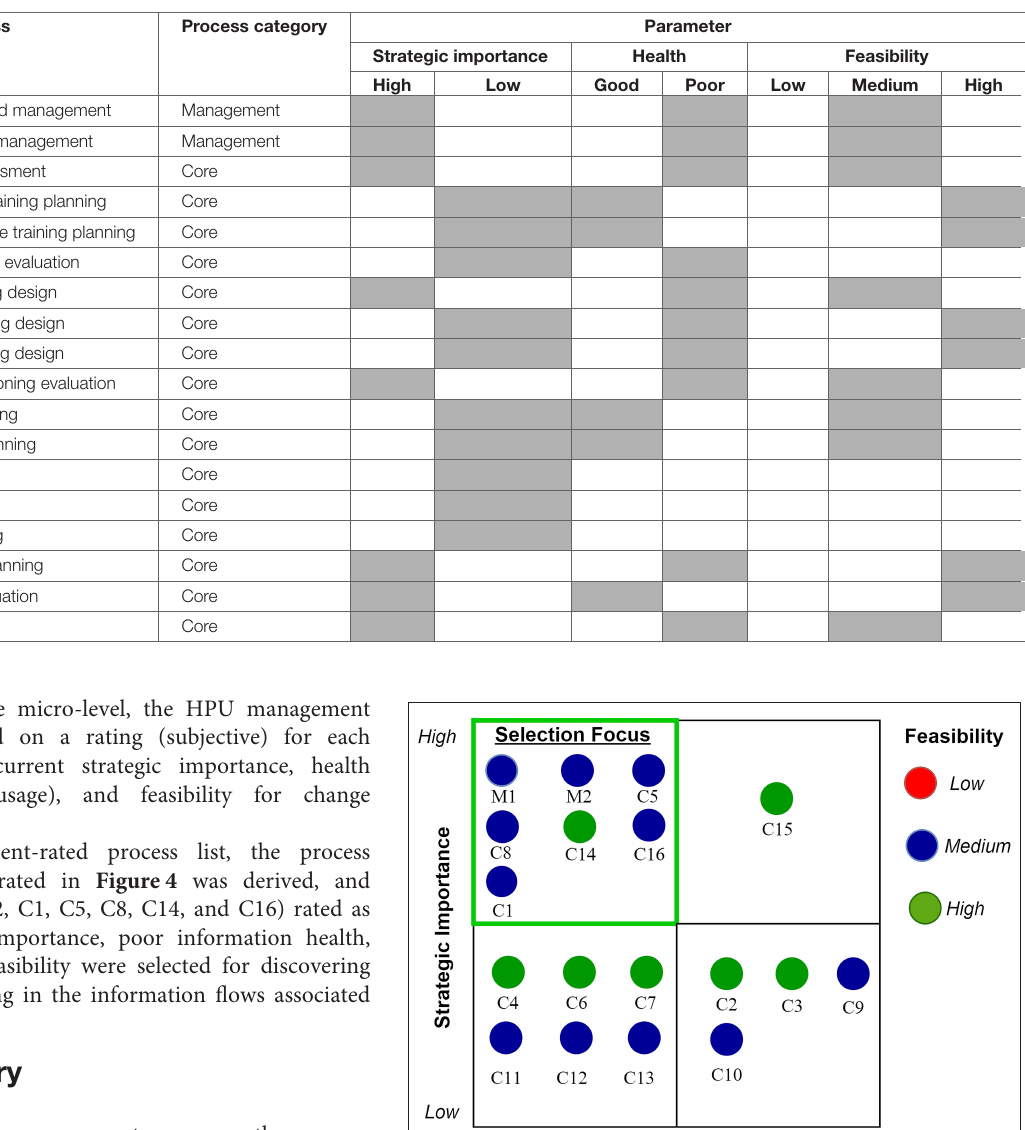
TABLE 3 | Process prioritization ratings.